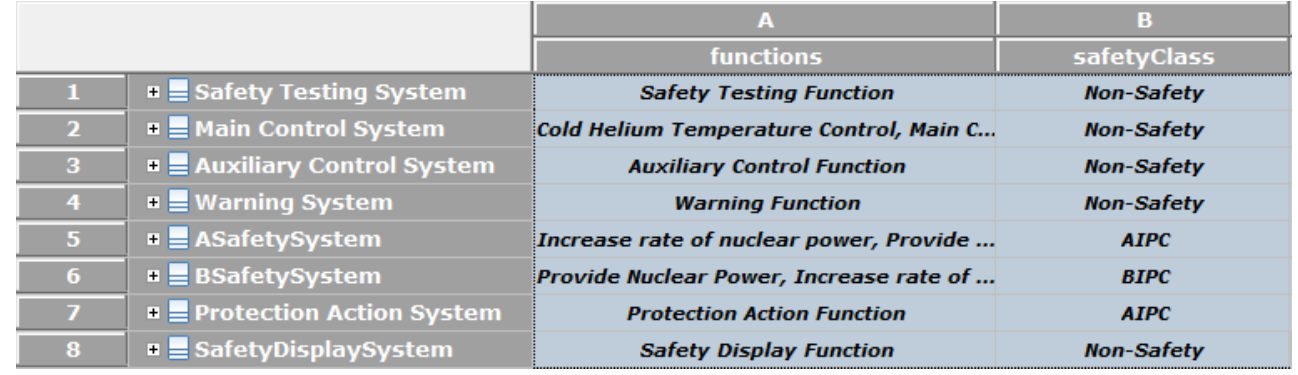
Figure 15. Safety class and associated safety features of systems on the